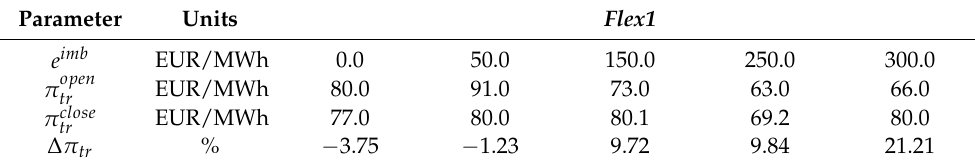
Table 6. Effect of information asymmetry of imbalance price for the Flex 1 agent on transaction prices. Parameter Units Flex1 e imb